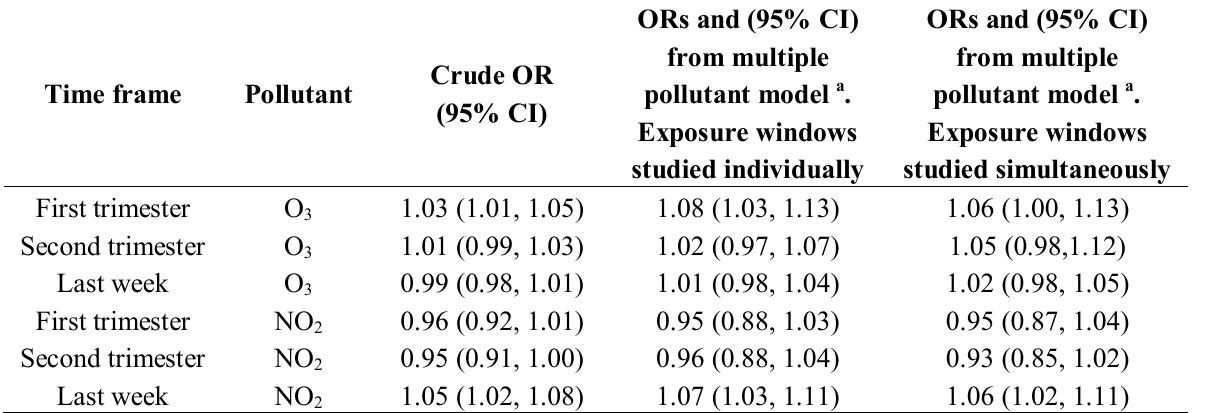
Table 4. Crude and adjusted ORs for preterm delivery per 10 µg/m 3 increase in pollutant concentration.